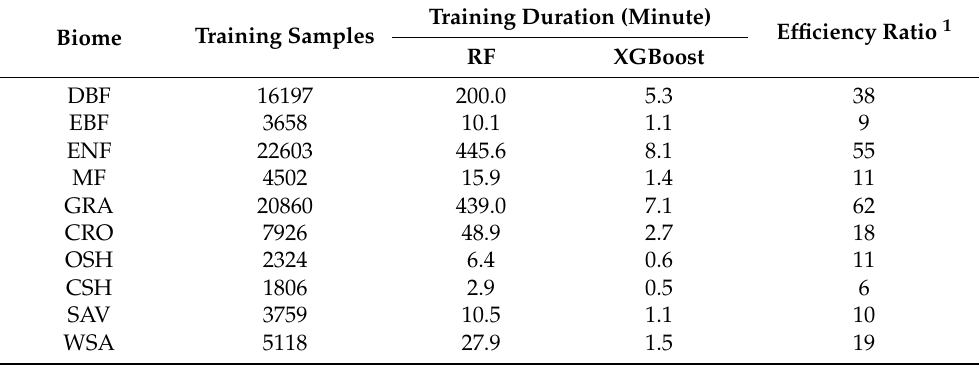
Table 3. Training duration for different biomes and